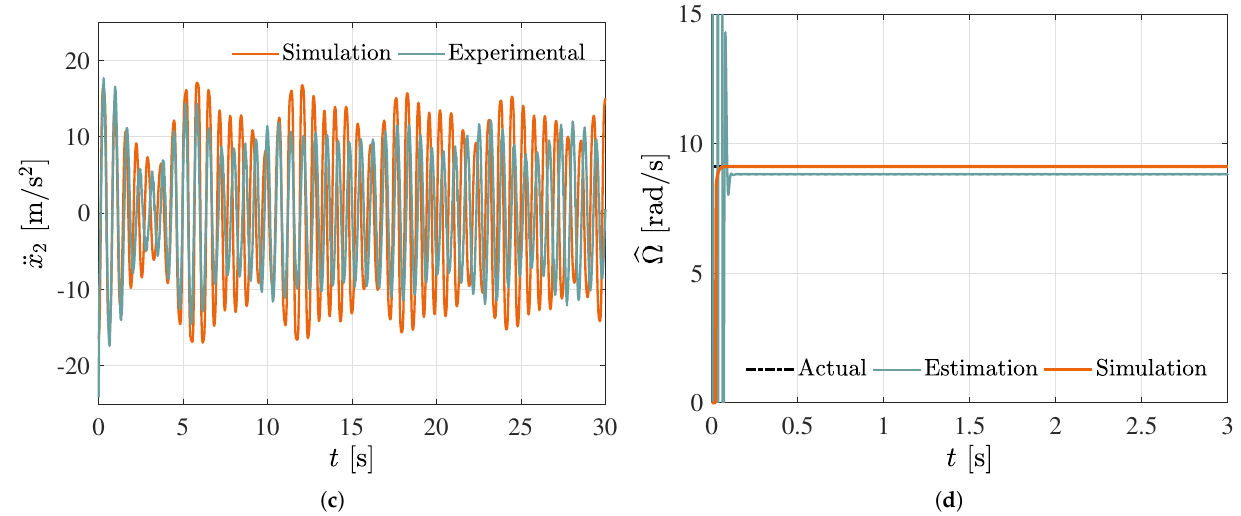
Figure 5. Acceptable frequency estimation using acceleration measurements on a damped distributed- parameter flexible structure for the second configuration. ( a ) Experimental and simulated accelera- tions of the primary structure; ( b ) acceptable experimental frequency estimation; ( c ) experimental and simulated accelerations of the vibration absorber; ( d ) simulation and experimental frequency